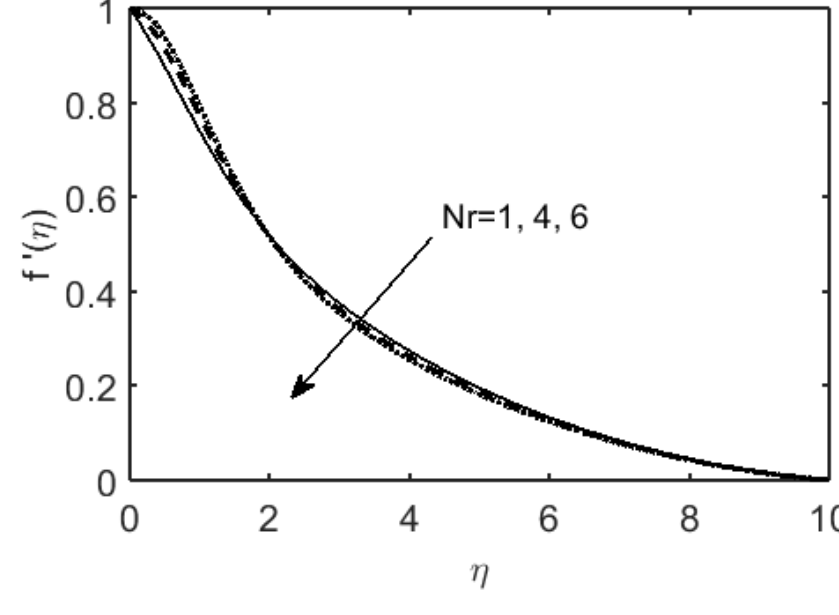
Figure 4. Impact of Nr on speed.